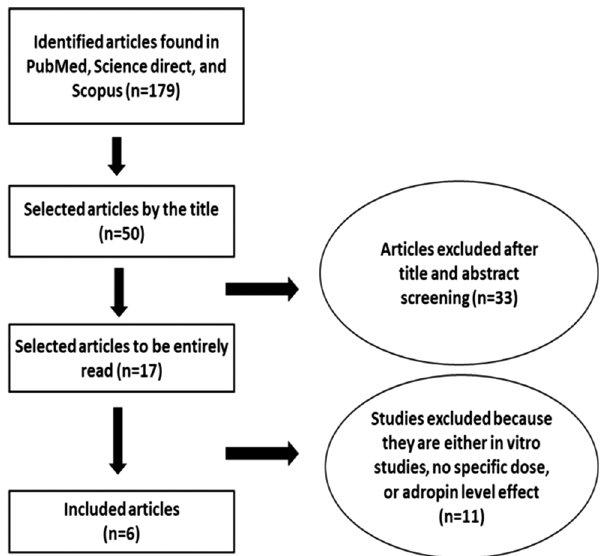
Figure-1: Inclusion criteria of systematic